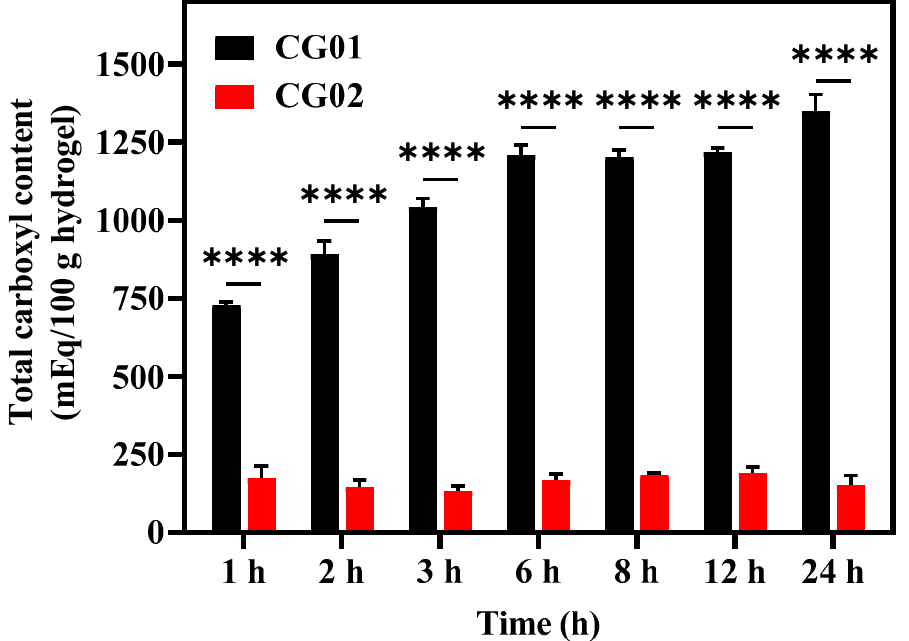
Figure 3. Total carboxyl content of CG01 and CG02 for different immersion times in crosslinker solution at room temperature. The results p < 0.0001 (****) were considered as significant in compared to